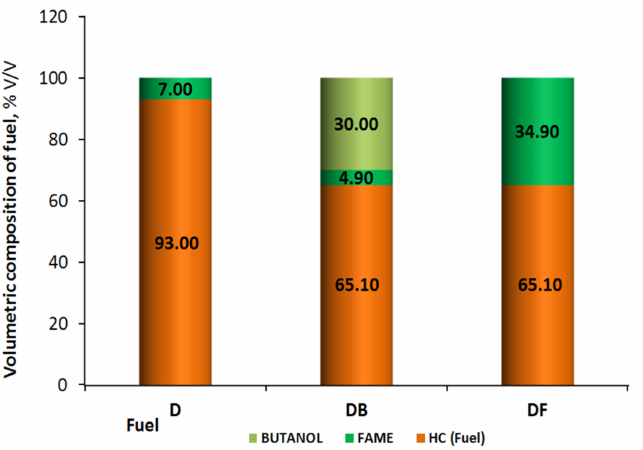
Figure 1. Volumetric composition of fuel for